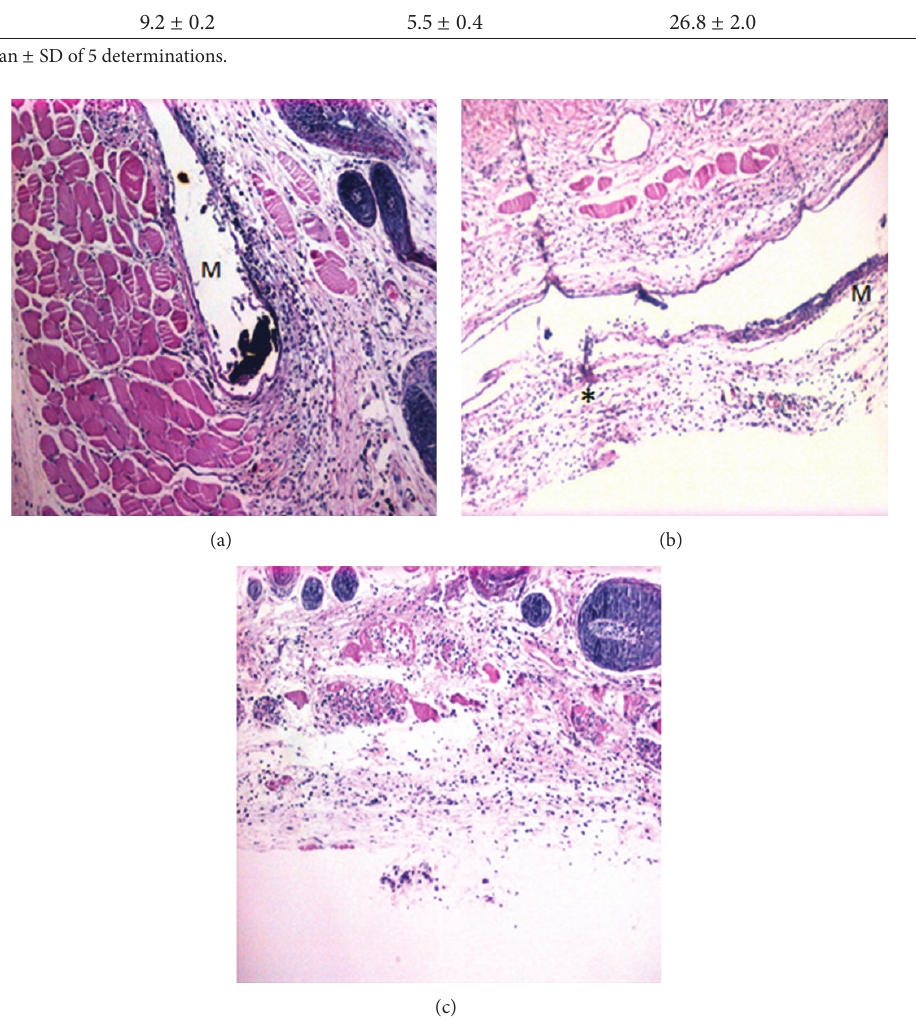
Figure 7: Photographs of sites one day after implantation of PLDLA/PCL-T membranes. (a) Site implanted with the 100/0 blend showing the formation of a fibrous capsule ( ∗ ) around the membrane (M) and an infiltrate of polymorphonuclear cells, (b) site implanted with the 90/10 blend showing a similar result to (a), and (c) control site showing an infiltrate of polymorphonuclear cells. Staining: hematoxylin and eosin (H&E). Magnification: